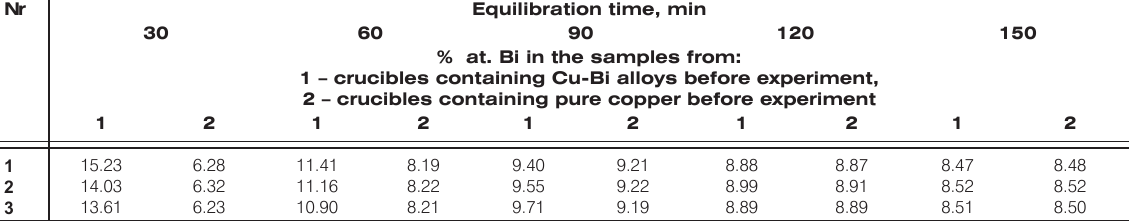
Figure 2. Ternary liquid phase molar Gibbs excess energies ( ∆ G E,LIQ , J mol -1 ) calculated in this work according to various techniques: 1 – COST531([15], binary parameters only), 2 – this work, up to GSM [22,23], 3 – COST MP 0602 ([29], binary parameters only), 4 – this work, up to Kohler [20]. The calculations are done at 1700 K, along a section with constant molar Bi/Sn ratio equal to 1/3. X is the nickel mole fraction. Table 2. Experimental details. Nr – number of the